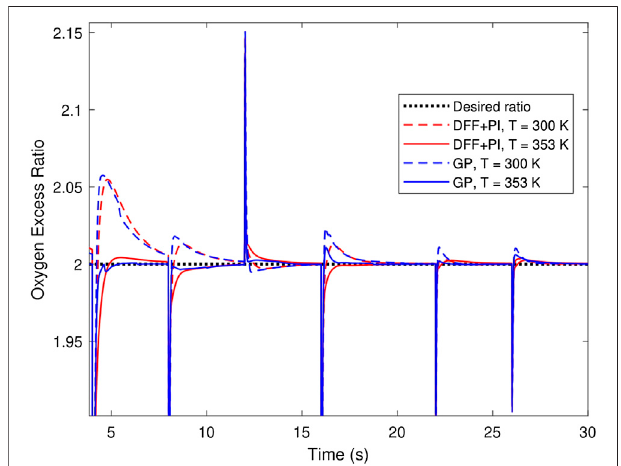
FIGURE 7 | GP and DFF + PI comparison for OER regulation.